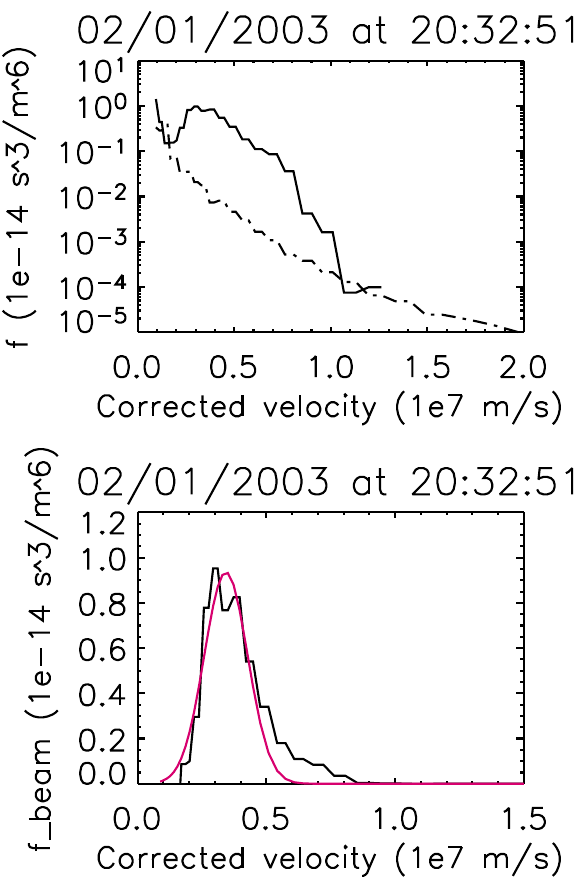
Fig. 5. Distribution function f of 2 January 2003 at 20:32:51 UT as a function of the measured velocity corrected from the spacecraft potential. Top panel: upward component: f // tot (full curve), and the average of the 11 others: f p (dash-dotted curve). Bottom panel: distribution function f //b of the beam itself (black curve) and best Maxwellian fit (red curve).